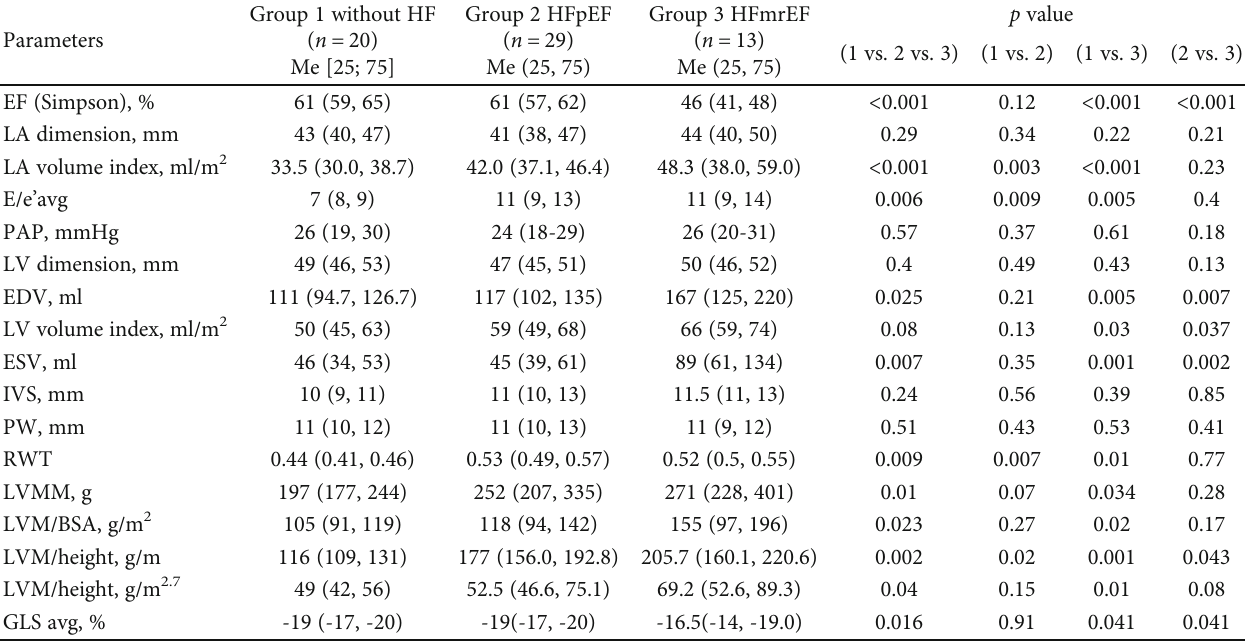
Table 2: Echocardiographic parameters of patients, Me (25,